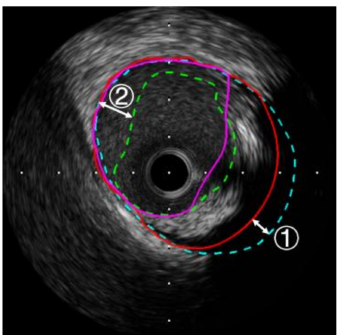
Figure 11. The analysis of the inaccuracy in the extraction of the MAB ( 1 (cid:79) ) and LIB ( 2 (cid:79)